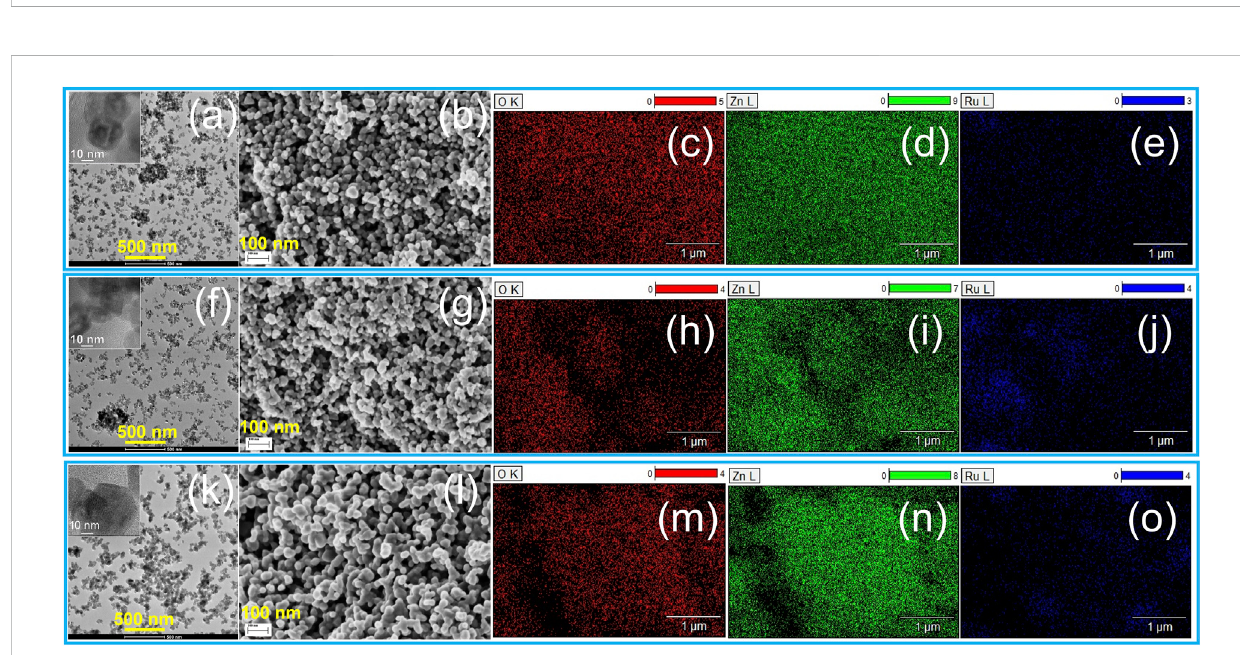
FIGURE 6 TEM/HRTEM and FESEM images with compositional EDX maps of Zn, Ru and O, of the 10ZnO@1RuO 2 particles: (A – E) as pristine, (F – J) annealed at 300, and (K – O) annealed at 600 ° C. Bar is 500 nm in the TEM images and 100 nm in the FESEM images.